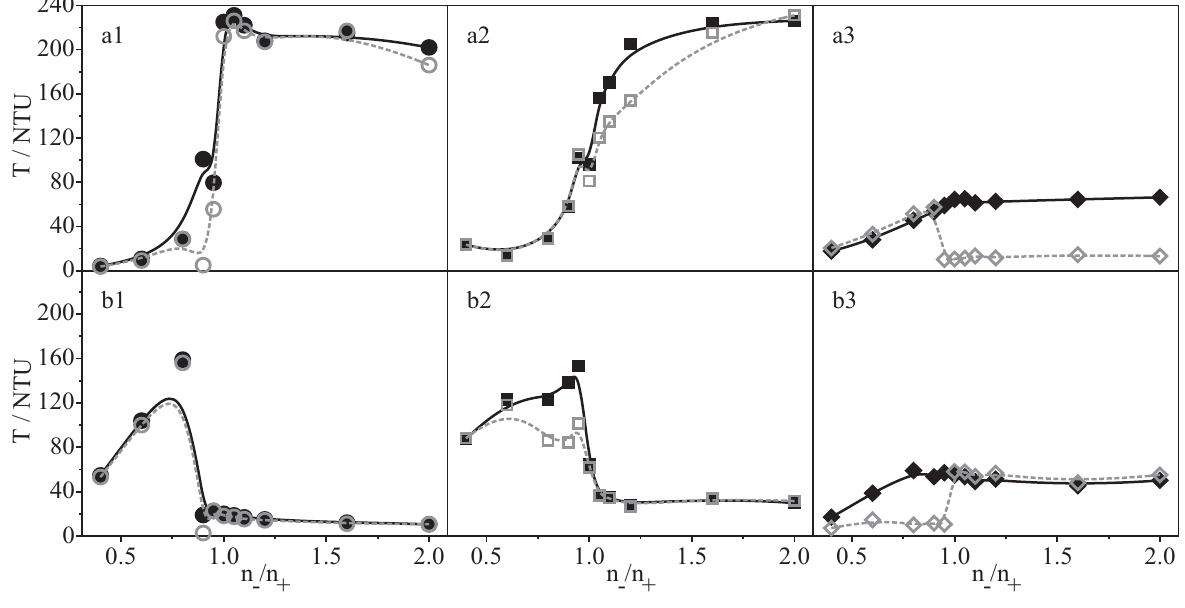
Figure 2. The turbidity of PEC dispersions in dependence on the n The measurements were made after 2 h (filled symbols) and after 24 h (open symbols).